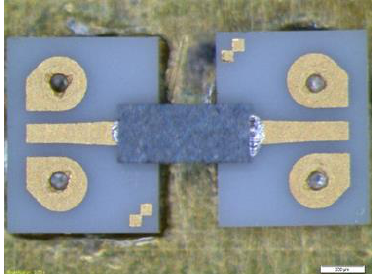
Figure 10. Photo of the ZBD in the flip-chip assembly.